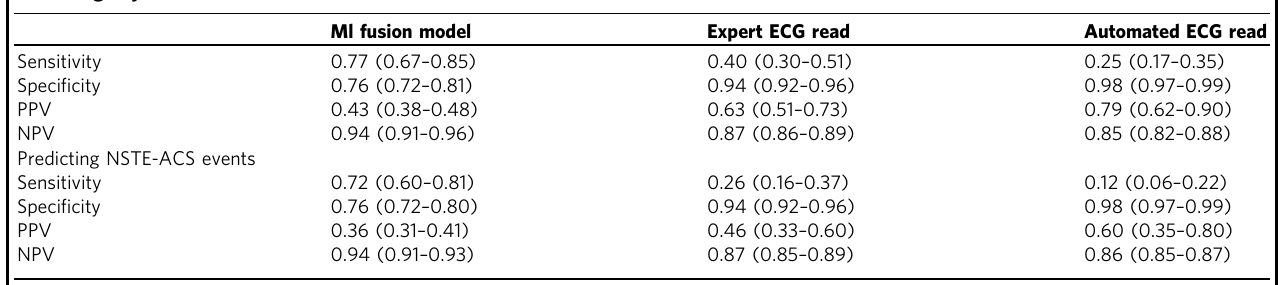
PPV, positive predictive value; NPV, negative predictive